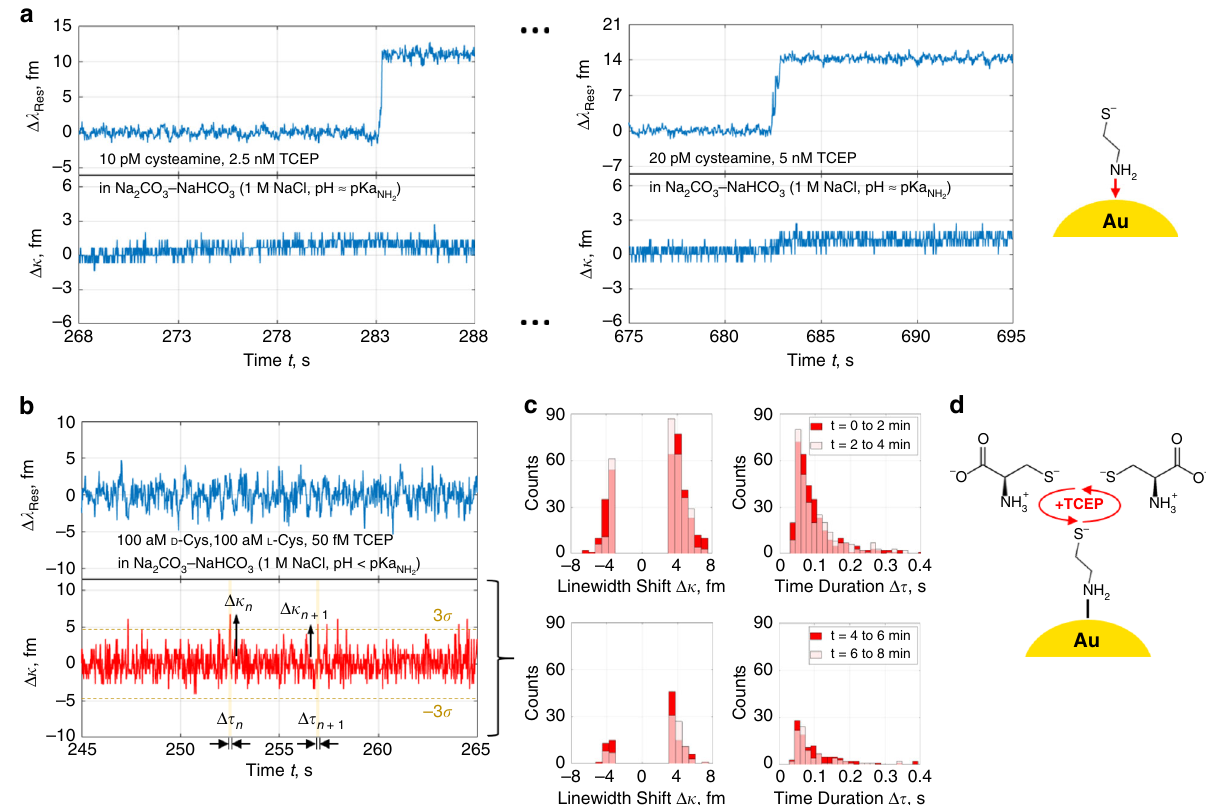
Fig. 4 Cysteamine pre-functionalisation and disul fi de events from converging DL -cysteine. a Binding of cysteamine to Au NRs via amine in basic buffer. b Linewidth fl uctuations induced by racemic DL -cysteine interacting with immobilised cysteamine thiolates at pKa employed here to counteract cysteine oxidation/dimerisation. c Linewidth shift Δ κ and event time duration Δ τ histograms extracted from the resonance trace of ( b ). The mean event rate of the Poisson distributions passed through an in fl ection point, decreasing from 0.01 aM − 1 s − 1 to 0.003 aM − 1 s − 1 within an 8-min interval as the diffusing cysteines were captured. d DL -cysteine and bound cysteamine transiently interacting via their thiol